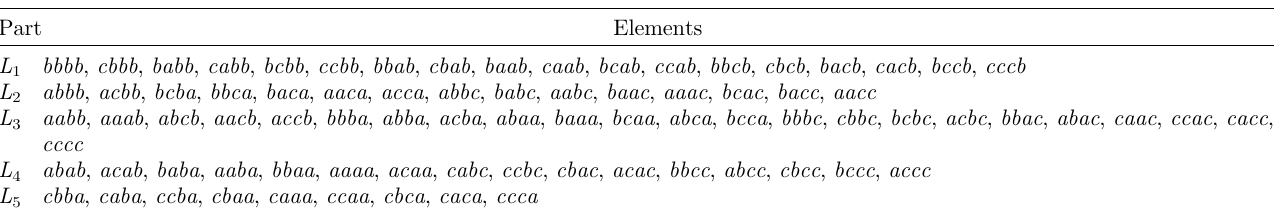
Table 2. Estimated partition for the state space { a , b , c } 4 – procedure (i). The elements of L 1 have the format b .. . b or c ... b and the elements of L 5 have the format c . .. a